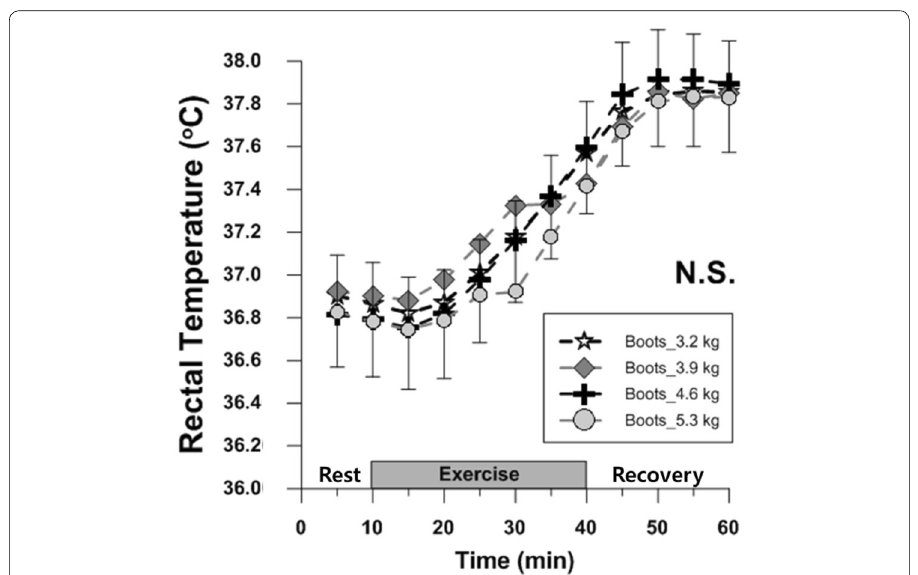
Fig. 2 The time courses of rectal temperature. * P < 0.05, ** P < 0.01, and *** P < 0.001. N.S represents not